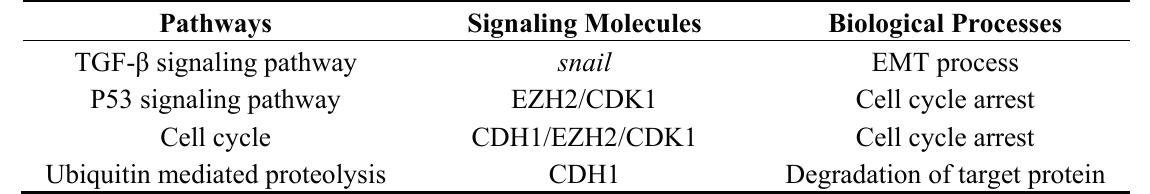
Table 4. HOTAIR -related signaling pathways/processes in